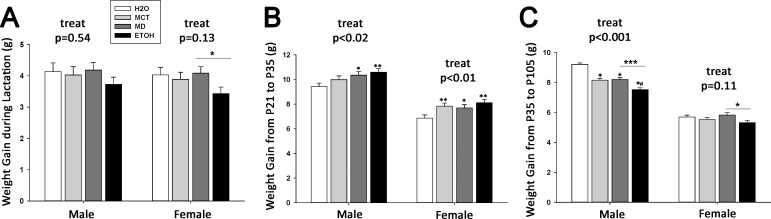
Prenatal treatment differentially affects offspring weight and weight gain over the lifespan.(A) During the lactation period, ETOH offspring gained less weight than did other groups, and this decreased weight gain was significant in female ETOH offspring in comparison with MD controls (p<0.05). (B) During the juvenile period (P21-P35), both male and female ETOH offspring gained significantly more weight in comparison to other groups (M: p<0.02; F: p<0.01). (C) During adolescence and adulthood (P35-P105), ETOH offspring gained less weight than other groups (M: p<0.0001 vs all other groups; F: p<0.05 vs. MD), despite their greater weight gain during the juvenile period. Values are mean ± SEM of more than 20 per sex*treatment group. * p<0.05 vs. H2O, ** p<0.01 vs. H2O, *** p<0.001 vs. H2O, # p<0.05 vs. isocaloric control (MD or MCT, as indicated by bar), using mixed linear factorial analysis of variance, followed by slice-effect ANOVAs with a priori hypotheses allowing for planned comparisons.